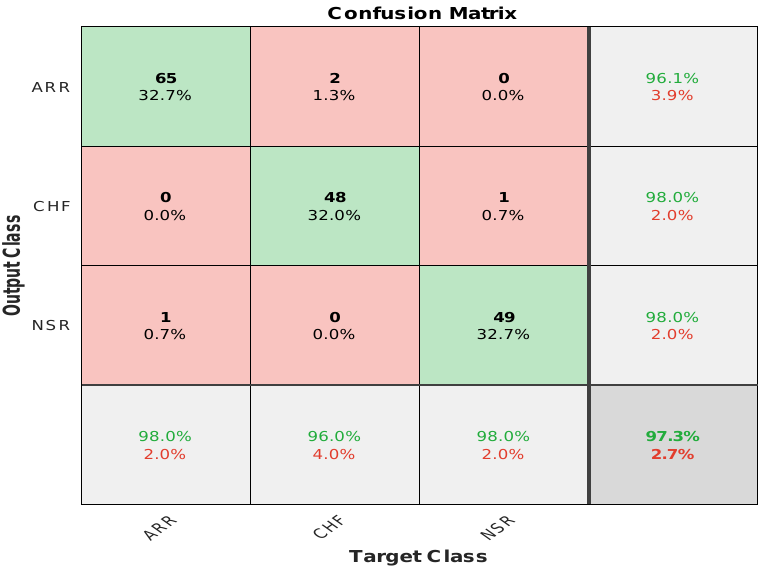
Figure 12. Confusion Matrix represents validation accuracy of proposed model with k-fold cross validation 2D-CNN-LSTM